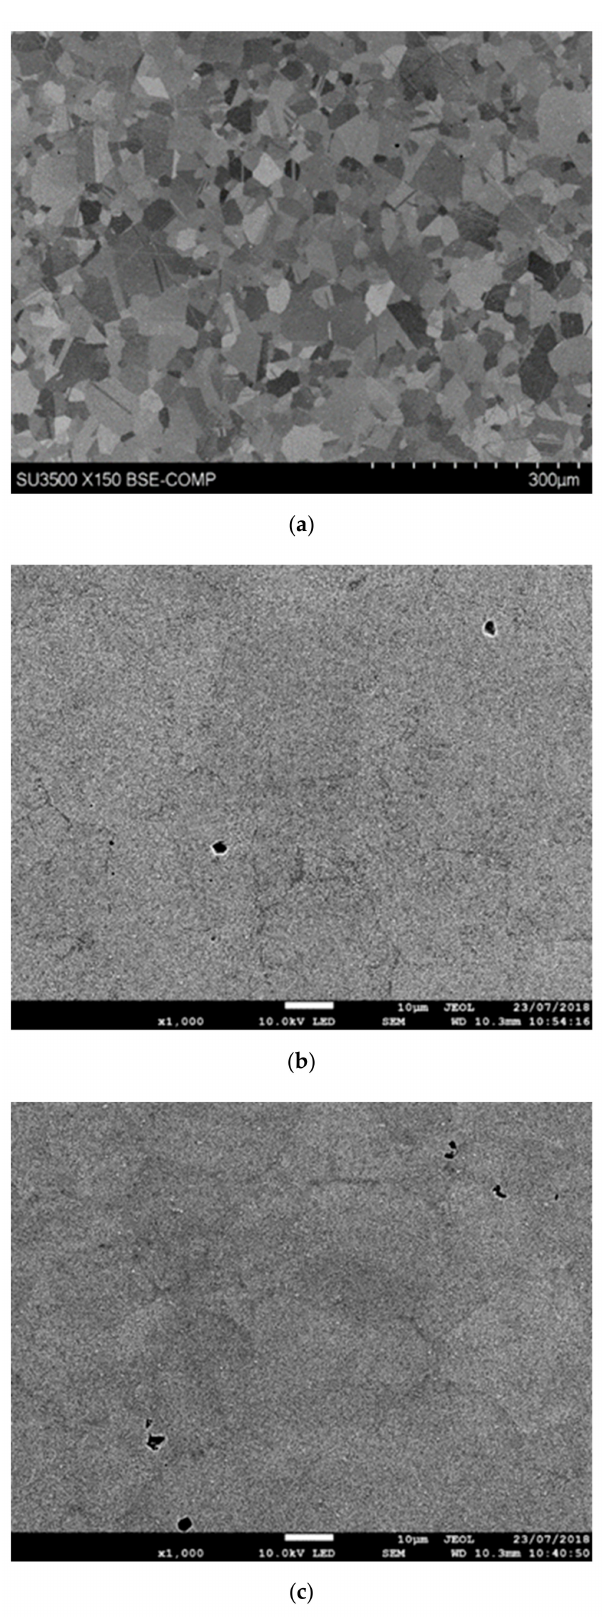
Figure 3. ( a ) Scanning Electron Microscope (SEM) images of as-received base material ( b , c ) FEG SEM images of as-received base